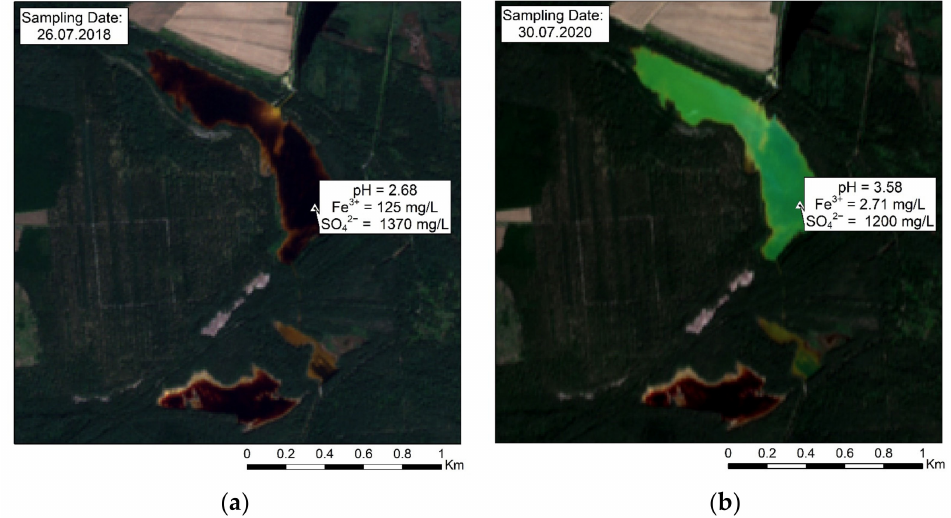
Figure 7. Measurements of pH value, Fe 3+ , and SO 42 − in the “Grüner See”, collected ( a ) in July 2018 with AMD and ( b ) in July 2020 after treatment of acid mine water with hydrated lime. Background images are natural color Sentinel-2 RGB-composites acquired during ( a ) 20 July–10 October 2018 and ( b ) 25 July–5 August